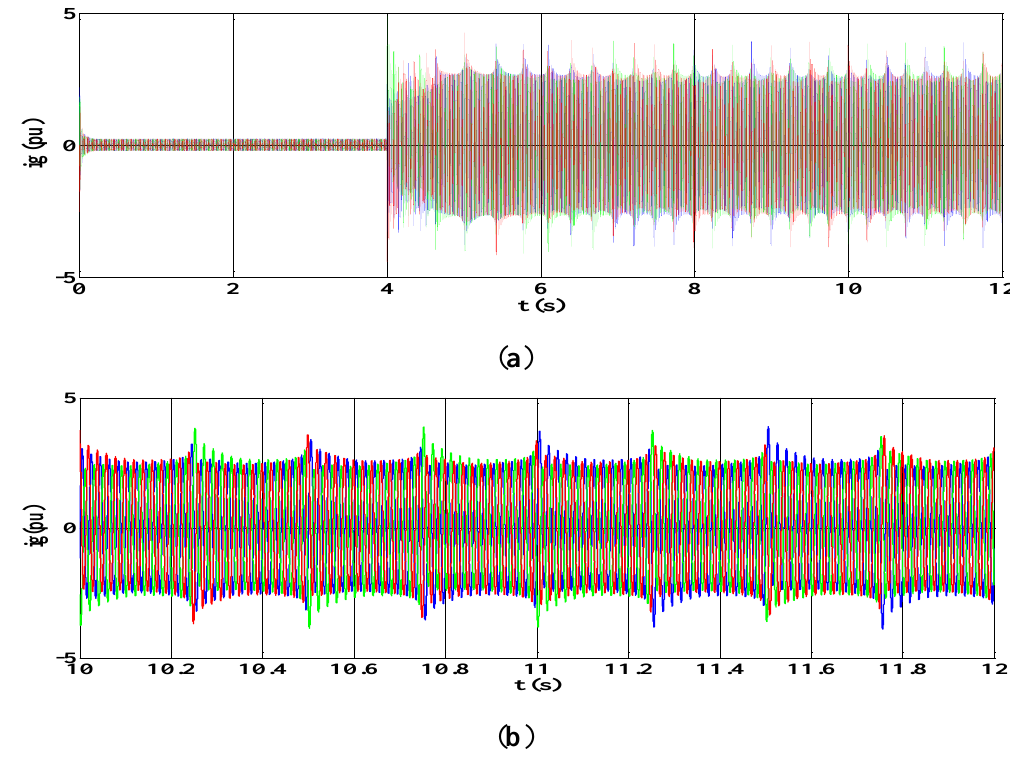
Figure 28. ( a ) GSC line currents (short-circuit happens at t = 4 s), ( b ) zoom of (a).